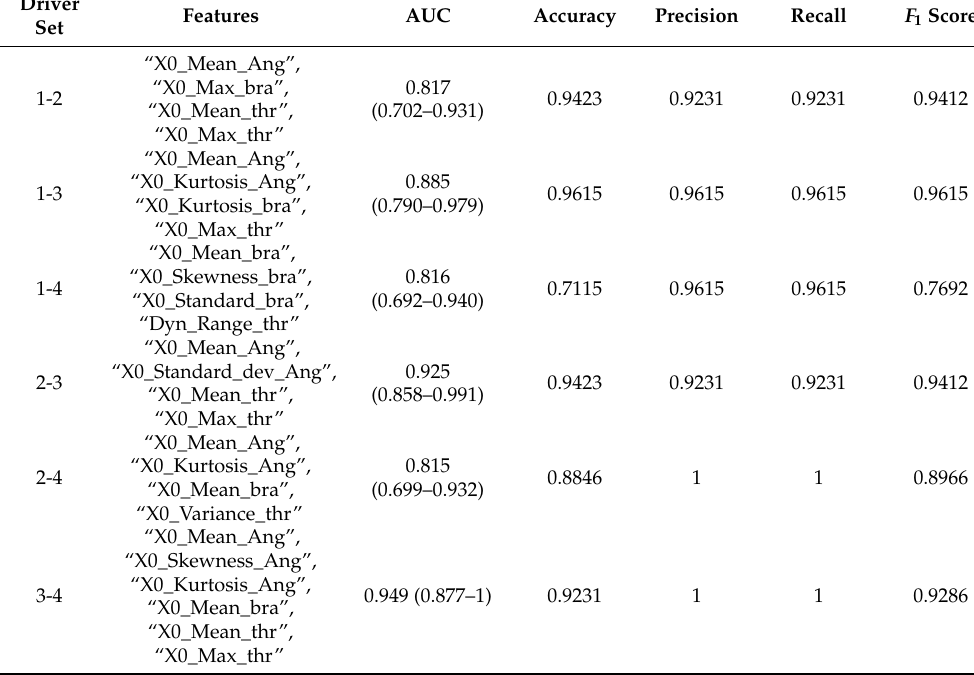
Table 3. LASSO selection with Random Forest model implementation metrics.